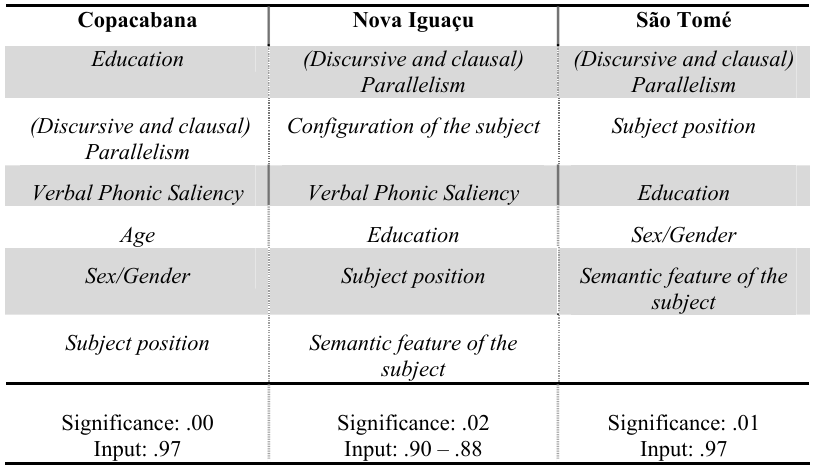
Table XII: Operating variables for implementing third person plural verbal marking by